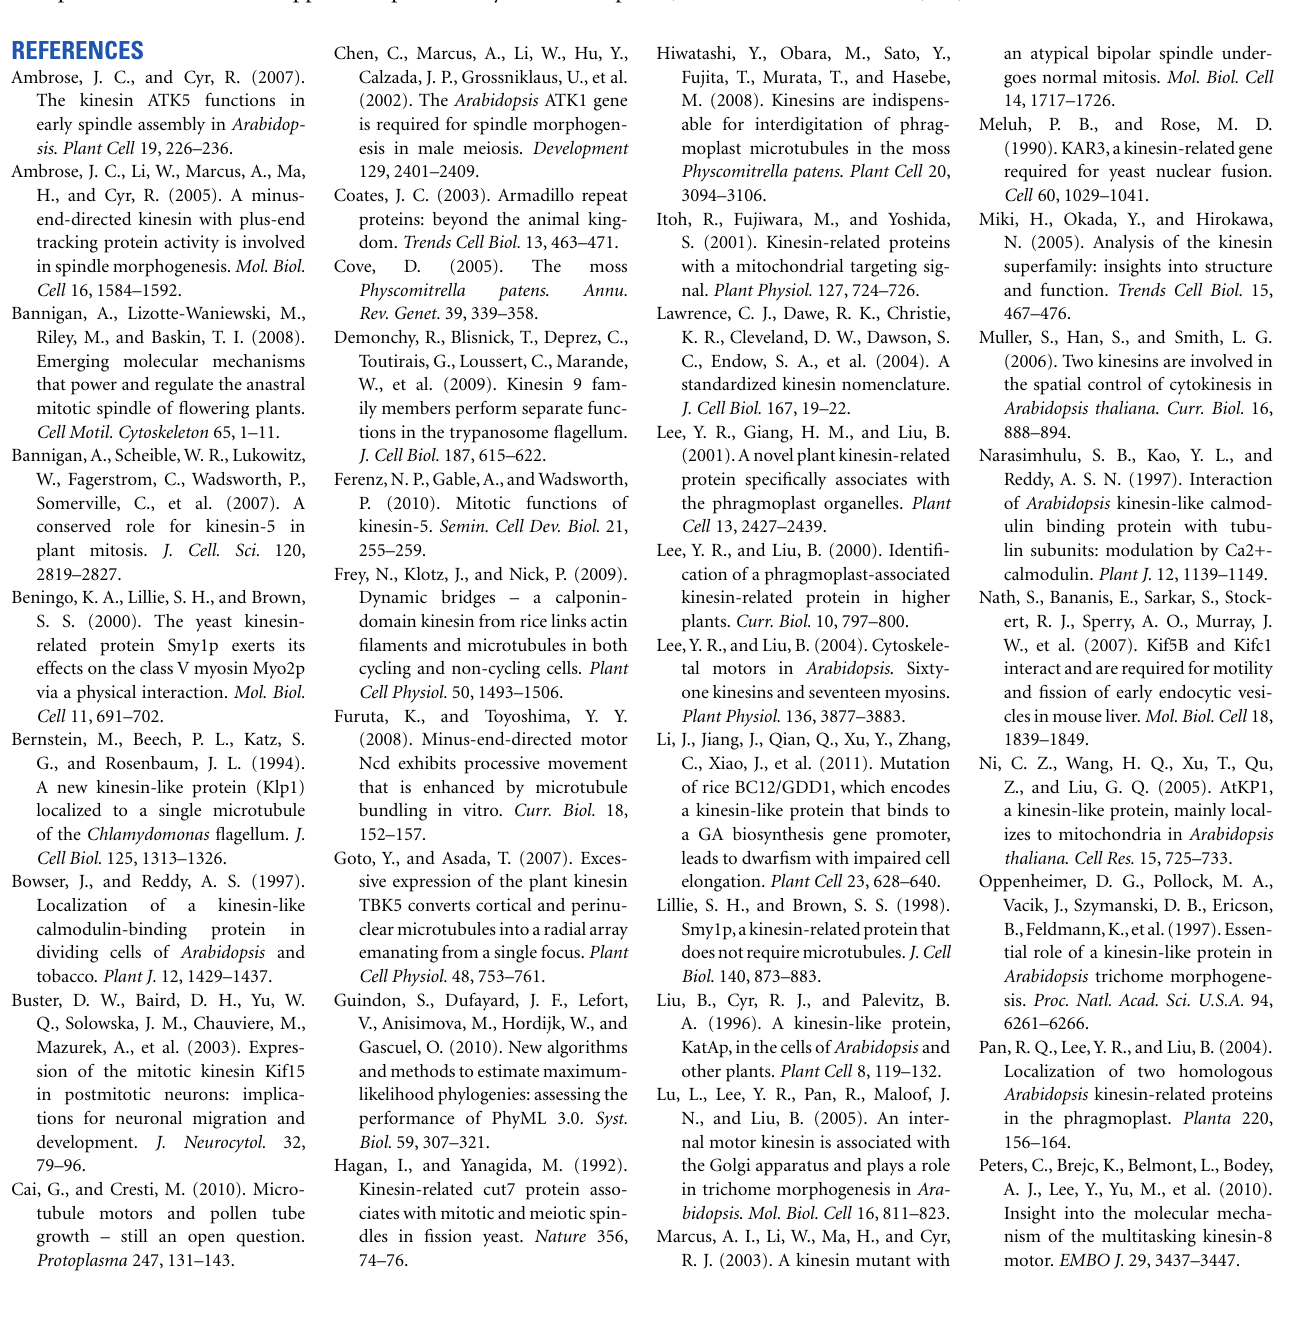
Figure S1 | Updated sequences for Pp-Kinesin09-b, Pp-Kinesin09-c, and Pp-Kinesin14-Vb. The bold sequences indicate exons absent from the Phytozome database.These sequences were updated from the genomic sequence information available on JGI (www.jgi.doe.gov) by aligning representative kinesins from multiple